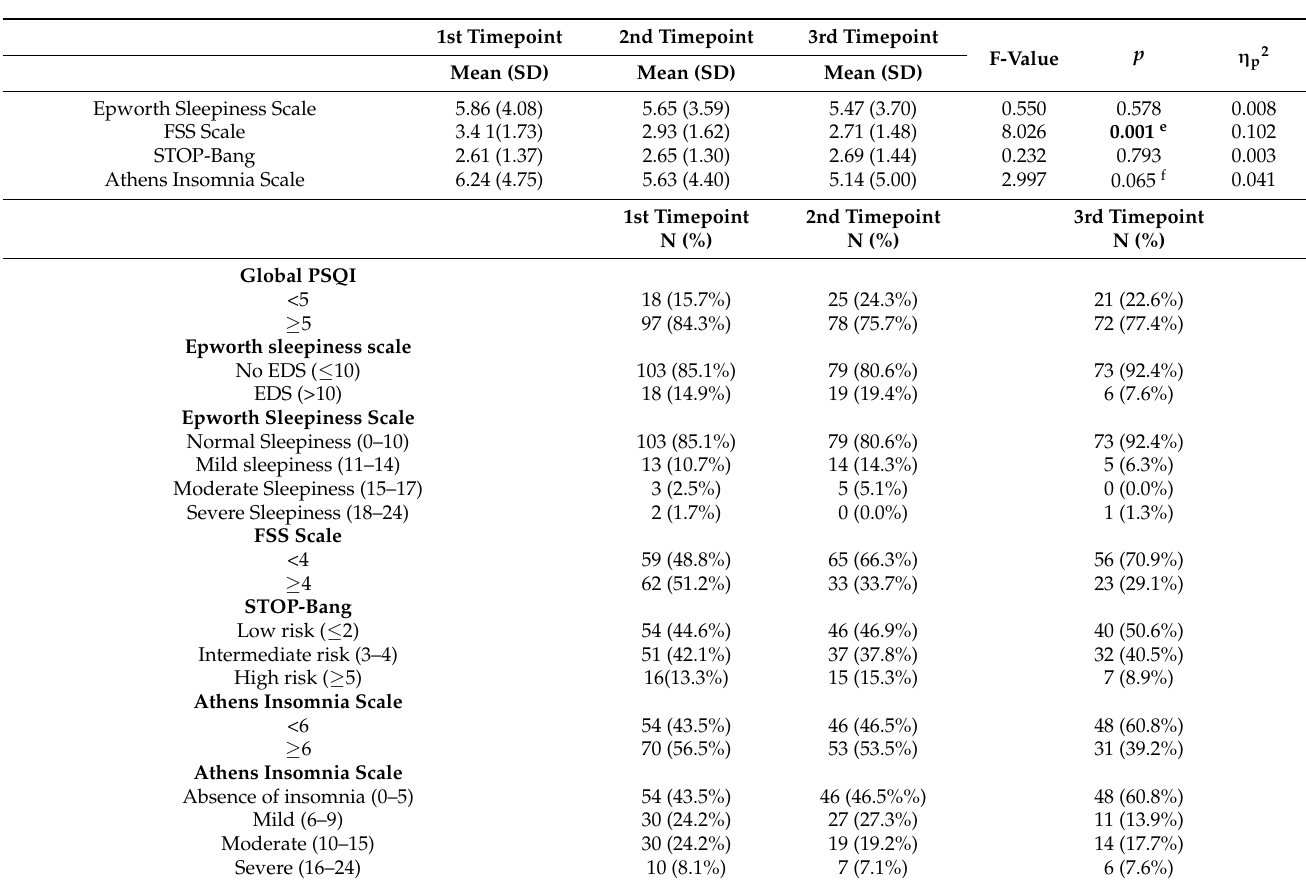
Table 3. Changes in the different assessment tools over the three time